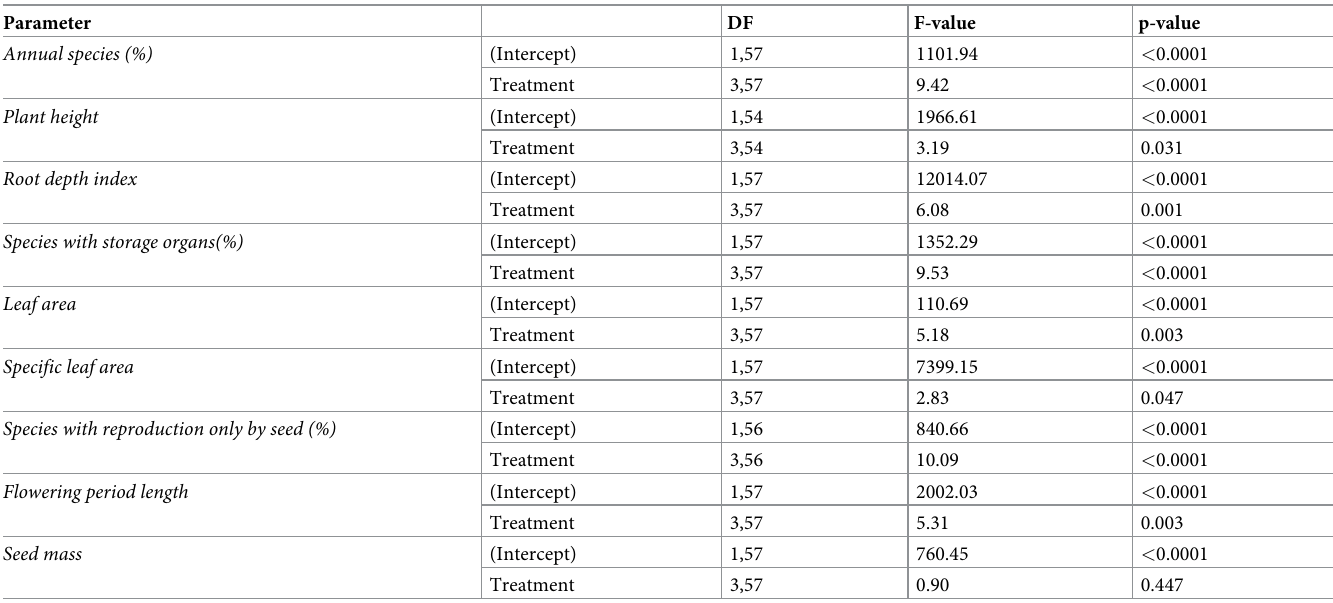
Table 2. Functional traits results.